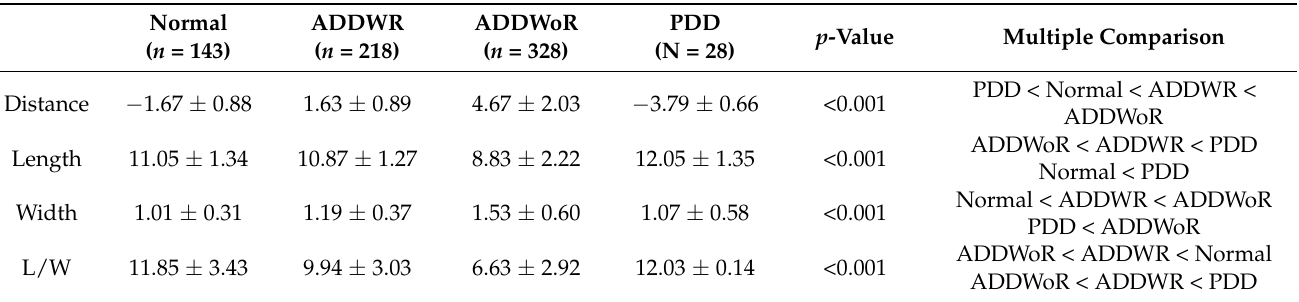
Table 5. Differences in disc quantitative measurements after adjusting for age and sex. ( a ) Differences in disc quantitative measurements among the three disc morphology categories after adjusting for age and sex a . ( b ) Differences in disc quantitative measurements among normal disc position, ADDWR, ADDWoR, and PDD after adjusting for age and sex a .